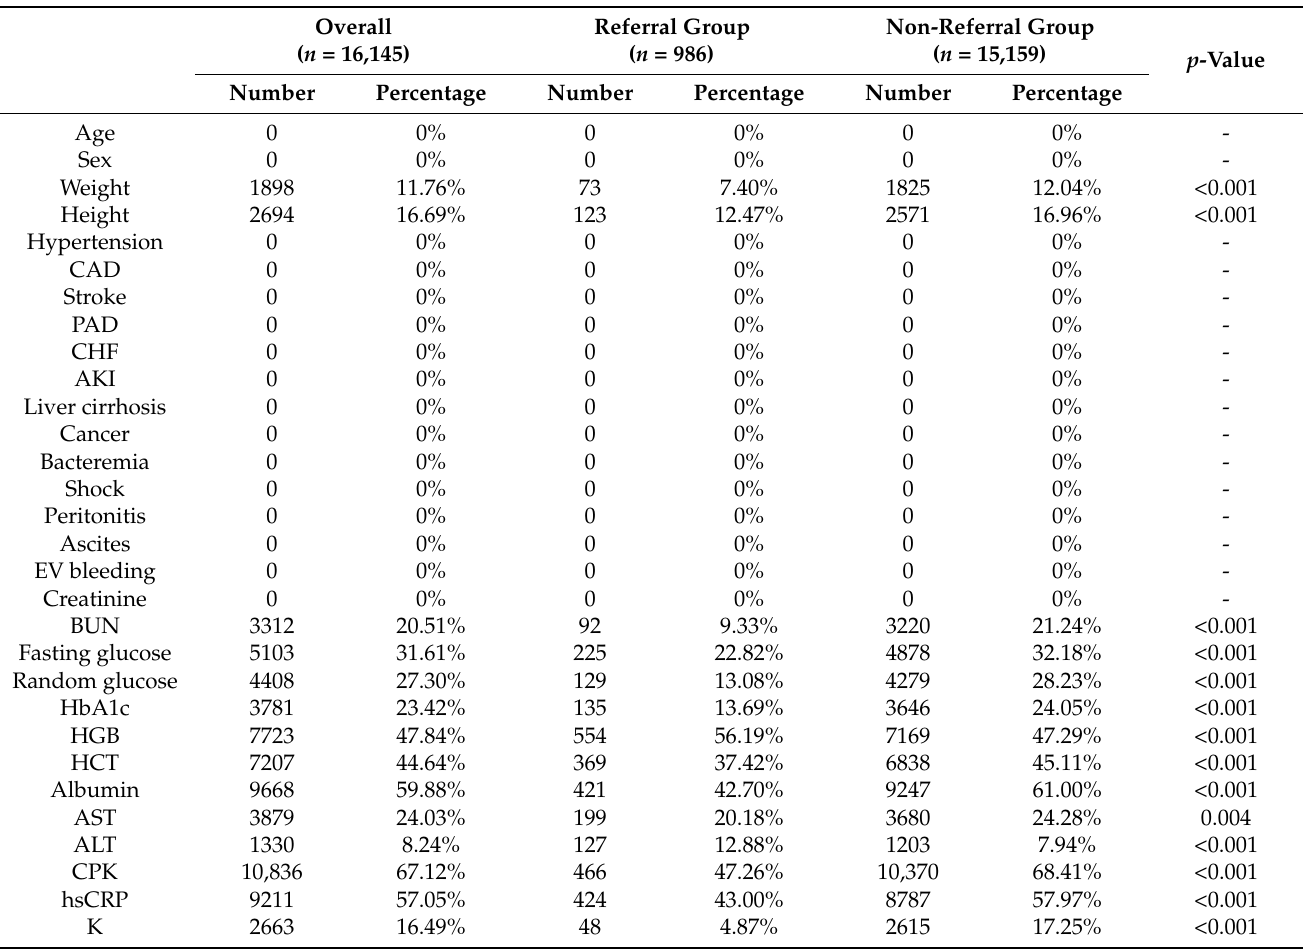
Table A3. Missing data in experiment